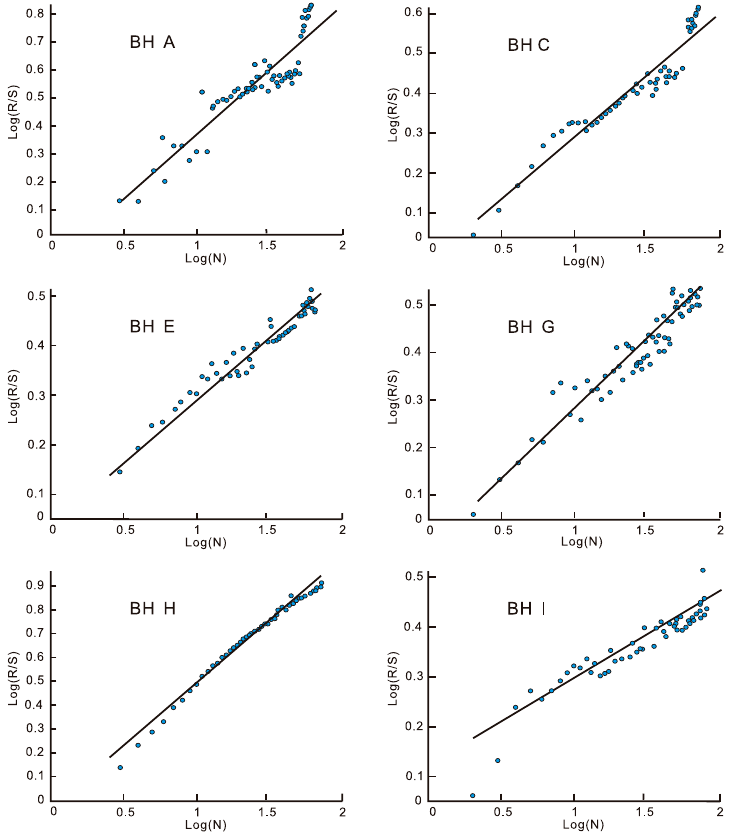
Figure 6. Log–log plots of R/S versus the number of samples (N).